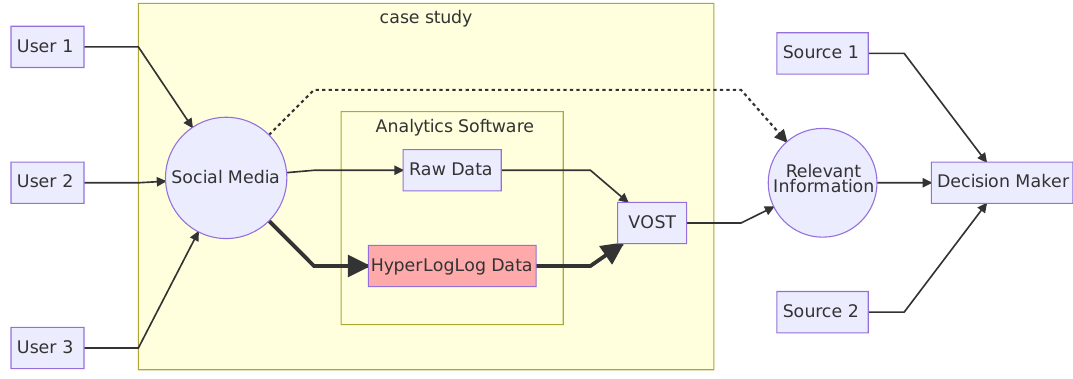
Figure 1. Users of social media services supply data, that is then parsed by analytics software, before the VOST evaluates it. Relevant information from social media is then passed to decision-makers, who found their decisions on it among other sources. The case study wraps up the part that involves social media, the analytics software and the VOST. We propose to base the analytics software on privacy-enhanced HyperLogLog data as a substitute to conventional raw